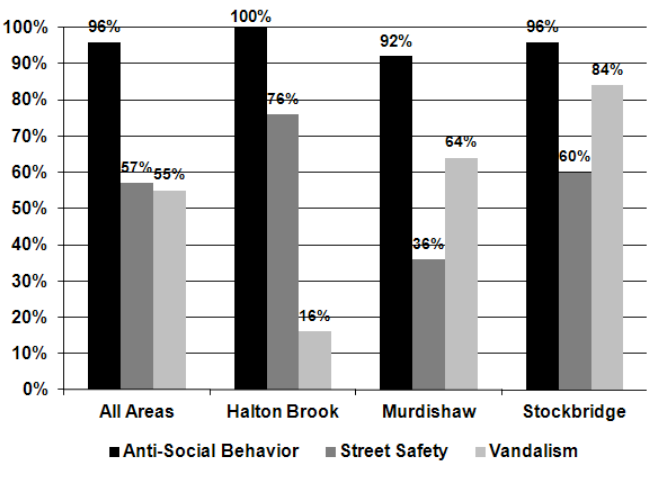
Figure 9. Community